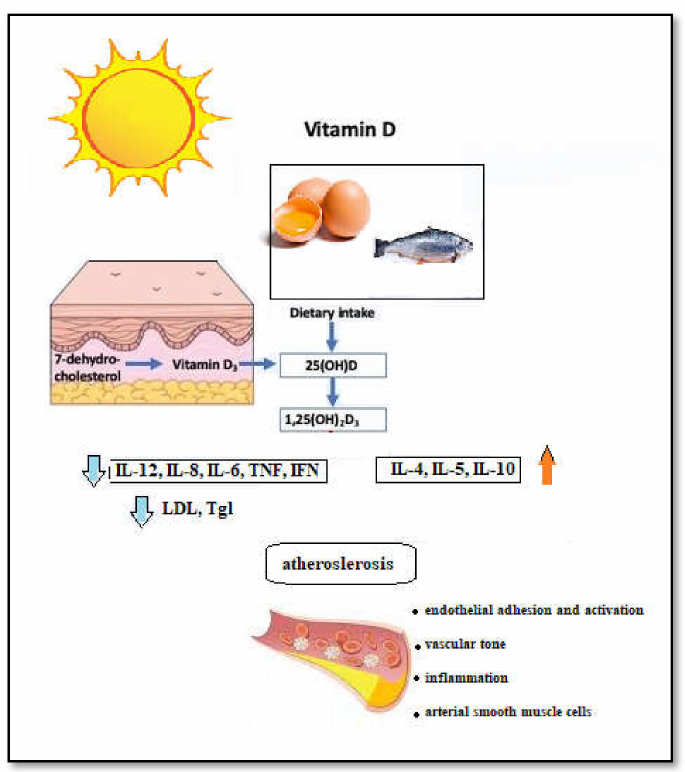
Figure 3. Mechanism of action of vitamin D on the process of atherosclerosis